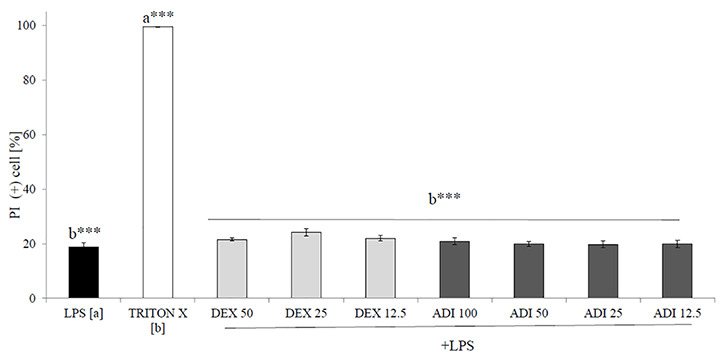
The cytotoxic effect of ADI at concentrations of 12.5 - 100 µg/mL on LPS-stimulated neutrophils after 24 h incubation [%], mean ± SEM. Statistical significance of differences was established by ANOVA with post hoc test, ***p<0.001, a*** - statistical significance of differences between LPS-stimulated control compared to control cells (Triton X), b - compared to control cells (Triton X).